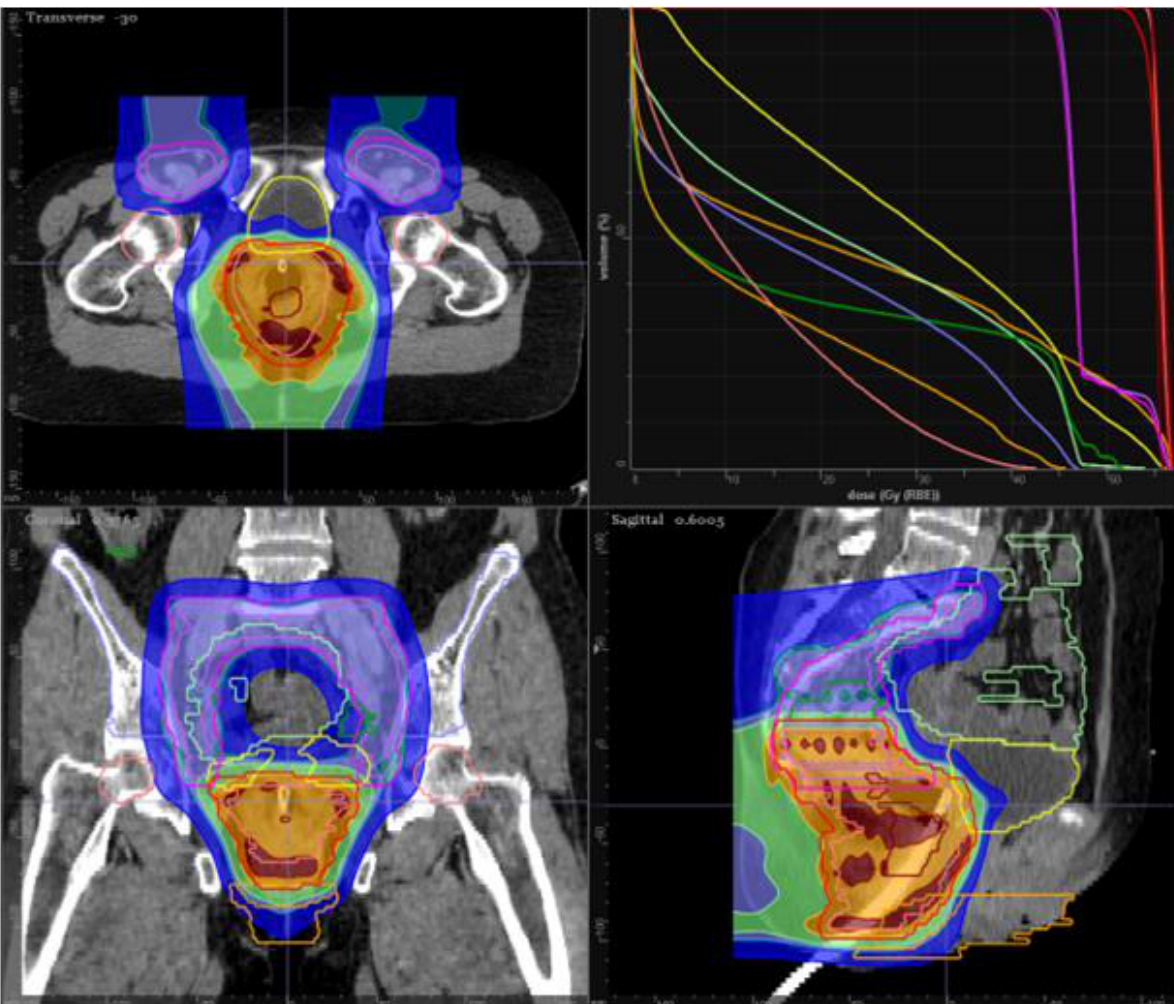
Figure 3. Example of pencil beam scanning proton plan for patient with early stage anal cancer. Elective inguinal nodes were treated with an AP field to 42 Gy. Elective upper pelvic nodes were treated to 45 Gy. Primary tumor and mesorectum treated to 50.4 Gy in 28 fractions.